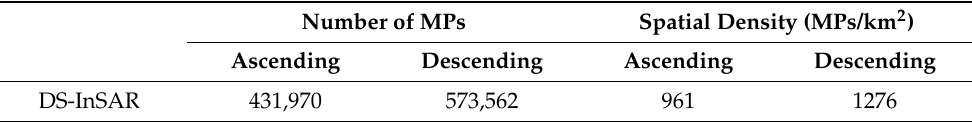
Table 3. Number and density of MPs detected in ascending and descending data.